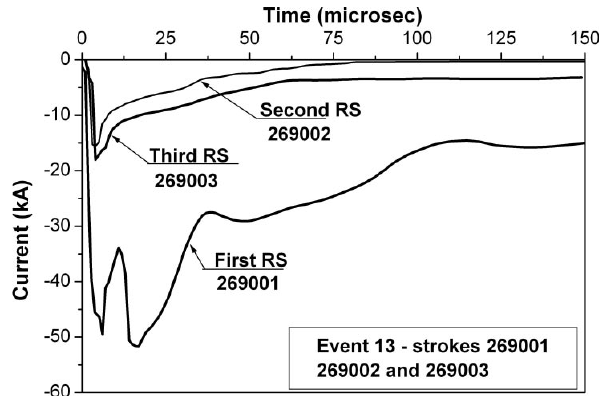
Fig. 2. Negative upward flash with 3 return strokes obtained at MC (event 15). The curve of the second stroke was not